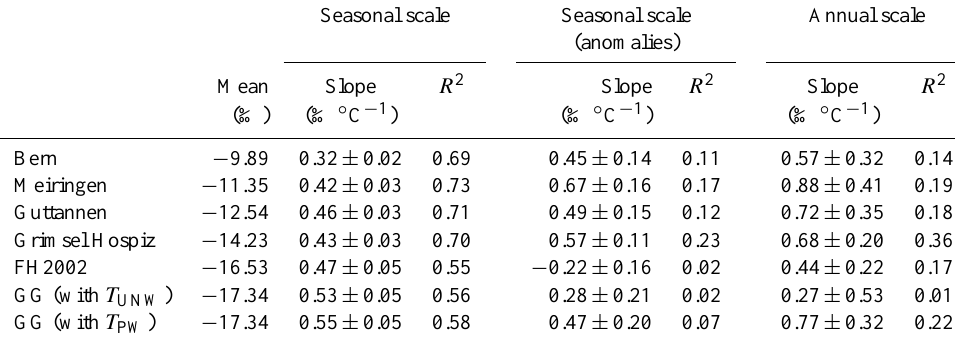
Table 1. Mean values of δ 18 O from the GNIP stations as well as from the ice cores over the common period 1971–1993, together with the slope of the long-term δ 18 O/temperature calibration and the R 2 for the seasonal and the annual scale. For the seasonal scale, values were calculated for the common period 1972–1993 (1971 and 1980 excluded because of gaps in the data). For the annual scale, the year 1980 was excluded. The temperatures used to calibrate the GNIP δ 18 O were measured at the respective stations, whereas for the ice cores the Jungfraujoch temperature was used for the Fiescherhorn and the Grand Saint Bernard for the Grenzgletscher. The suffix “UNW” stands for the unweighted average and “PW” for precipitation-weighted